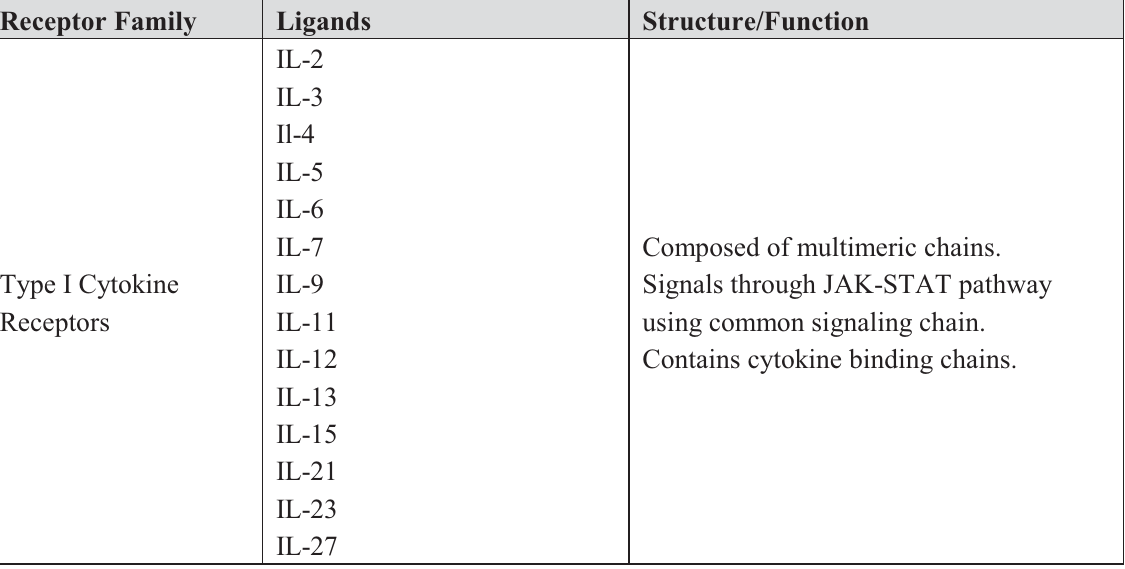
Table 2. Classification of cytokine receptor